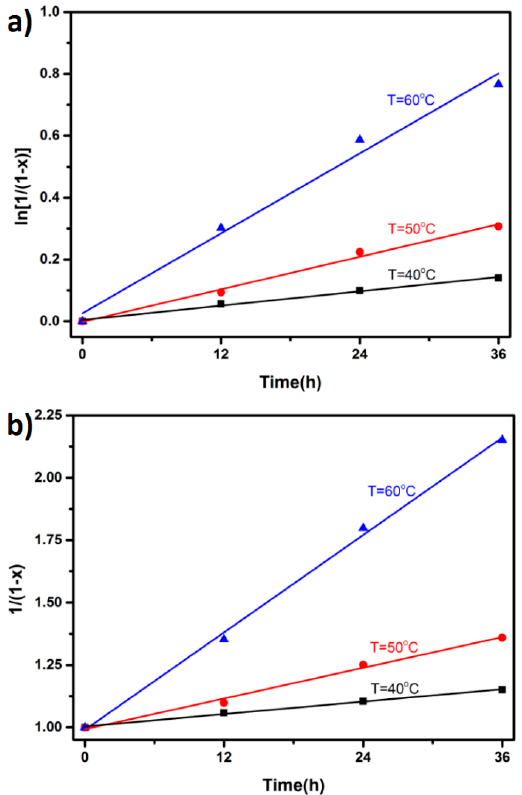
Figure 10. Linear fit of the data is conducted according to ( a ) first-order kinetics; ( b ) second-order kinetics.